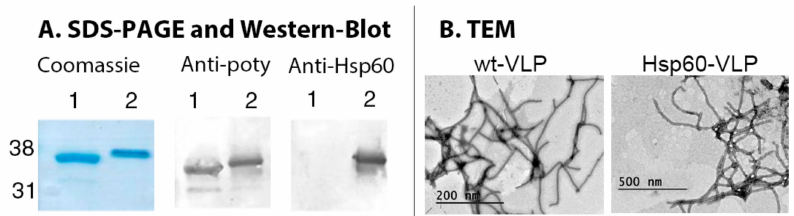
Figure 1. Hsp60-virus-like particles (VLPs) characterization. ( A ) SDS-PAGE and western blot of wild type VLPs (1) and Hsp60-VLPs (2). ( B ) Micrographs of wt-VLPs and Hsp60-VLPs, where particles